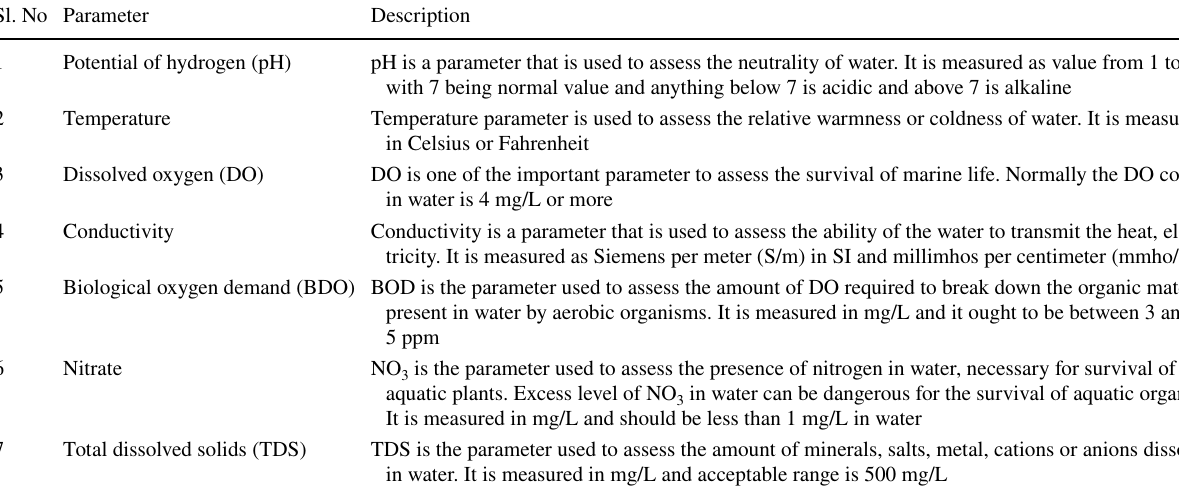
Table 1 The water parameters Sl. No